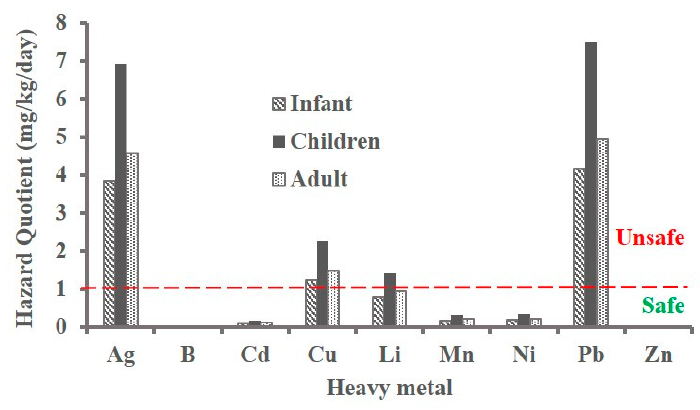
Figure 5. Non-carcinogenic risk (mean values) from drinking groundwater. Table 8. Correlation among metals in groundwater.